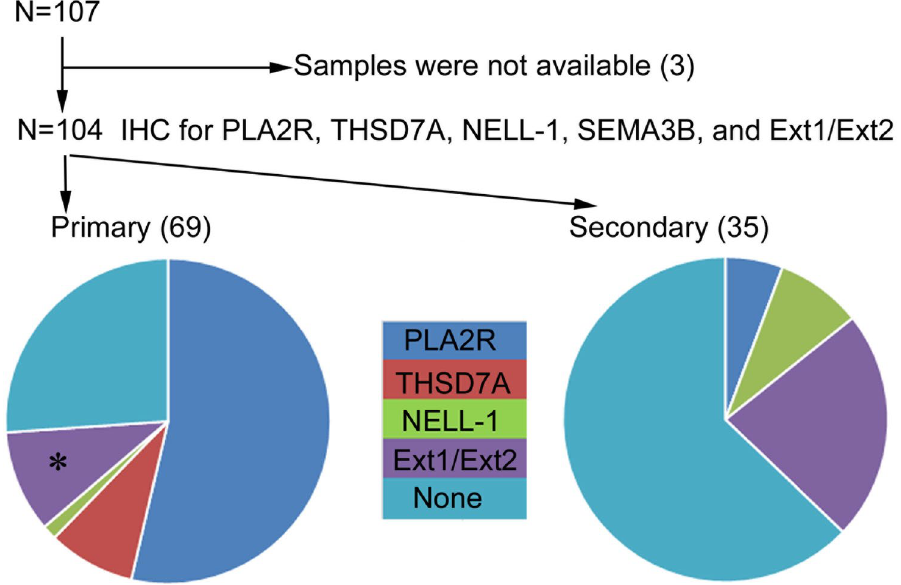
Figure 2. Flowchart of the patients’ classification. The percentage of each antigen in patients with primary and secondary MN is depicted in pie charts. MN membranous nephropathy, IHC immunohistochemistry, PLA2R phospholipase A2 receptor, THSD7A thrombospondin type-1 domain-containing 7A, NELL-1 neural epidermal growth factor-like 1 protein, SEMA3B semaphorin 3B, Ext exostosin. *Two samples with enhanced staining of Ext1/Ext2 also had enhanced staining of other podocyte antigens (one sample was positive for PLA2R, and another was positive for